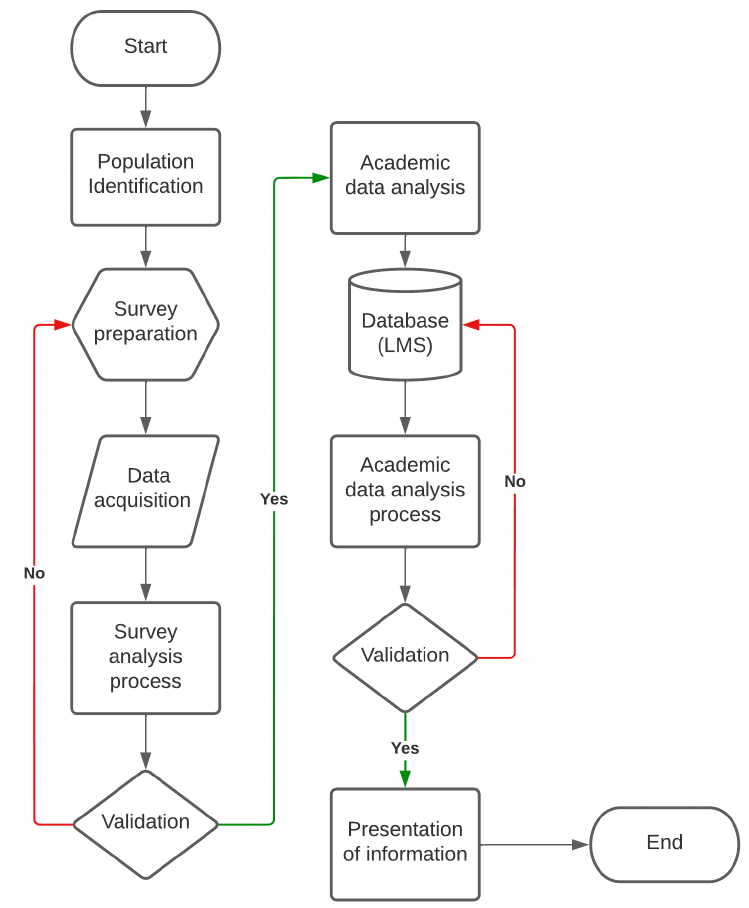
Figure 1. Flowchart for the creation of a survey validation method and data analysis.